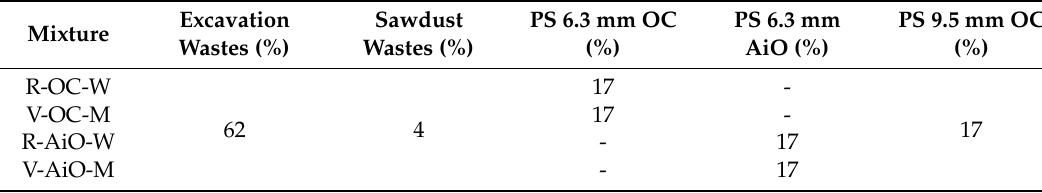
Table 1. Dosing of study mixtures.